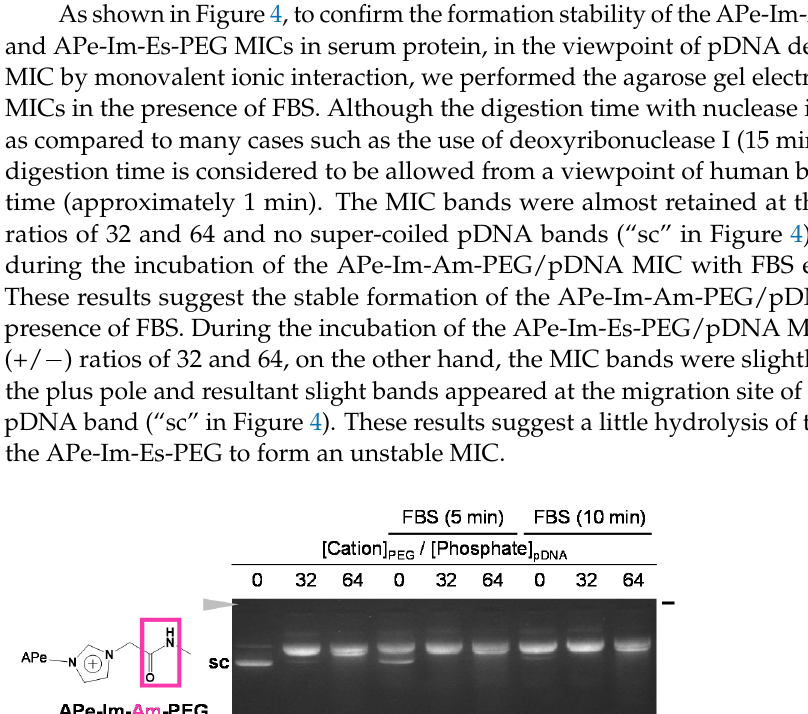
Figure 3. Representative TEM images of the APe-Im-Am-PEG/pDNA or APe-Im-Es-PEG/pDNA MICs. The mixing charge (+/ − ) ratios of the APe-Im-Am-PEG or APe-Im-Es-PEG to pDNA are indicated. Each scale bar represents 200 nm.